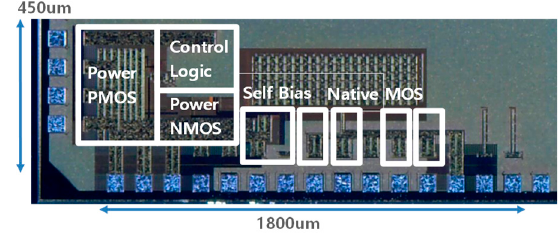
Figure 11. The chip micrograph of the proposed EMIC.